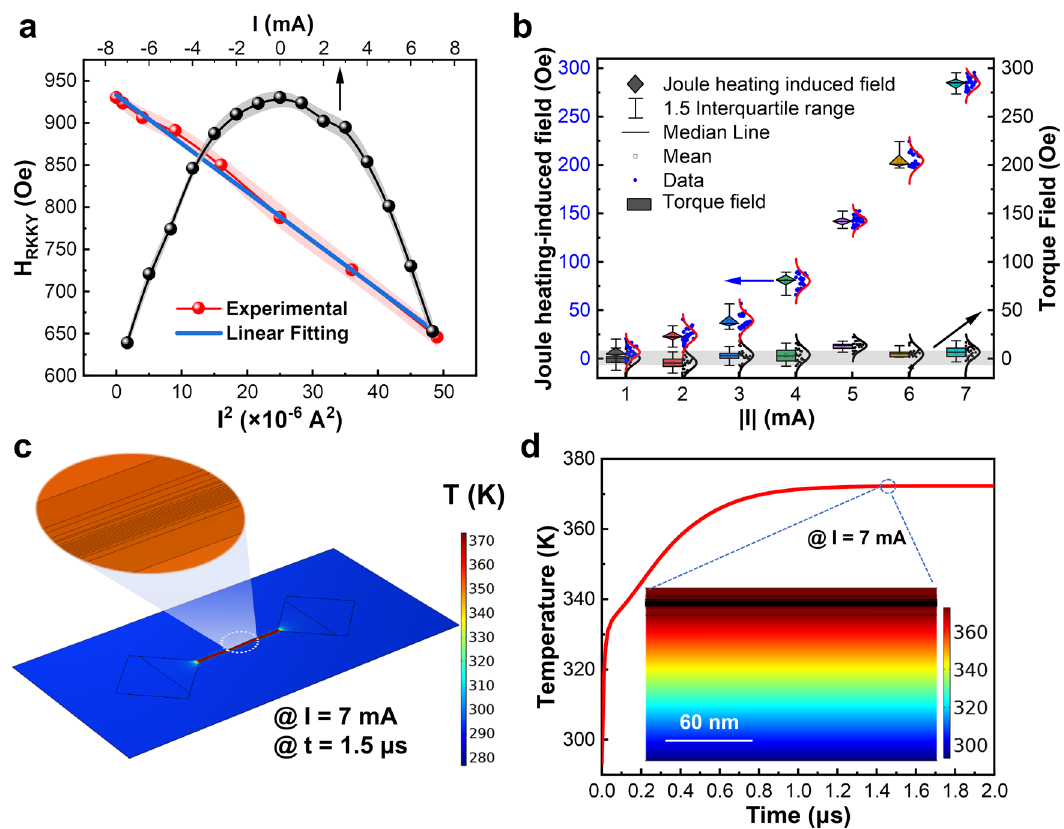
Fig.3|ModulatedRKKYandtime-andcurrent-dependenttemperatureeffects. a RKKYeffective fi eldasafunctionofthecurrentwithRKKYeffective fi eld vs I 2 .The bright red shaded areas represent error bars. b The dominant Joule heating- induced fi eld (JHIF) with a weak torque fi eld. c Simulated temperaturedistribution